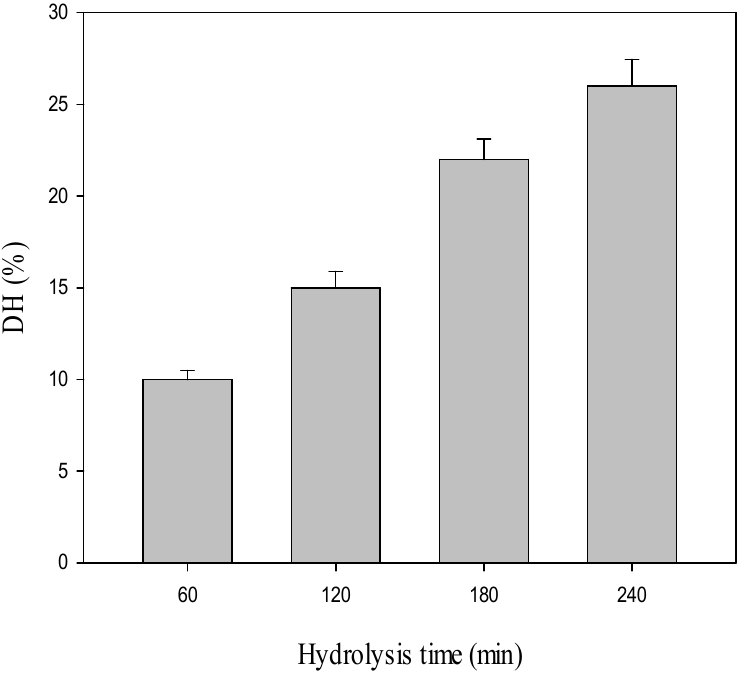
Figure 1. Degree of hydrolysis percentage (DH%) of cowpea protein hydrolysate (CPH) obtained by treatment with Alcalase (E/substrate ratio 1:200) for 240 min at 55°C and pH 7.8.